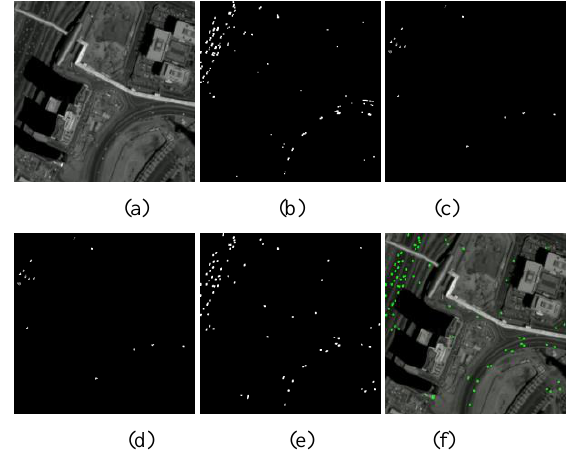
Figure. 5 Original data and all kinds of detection results of